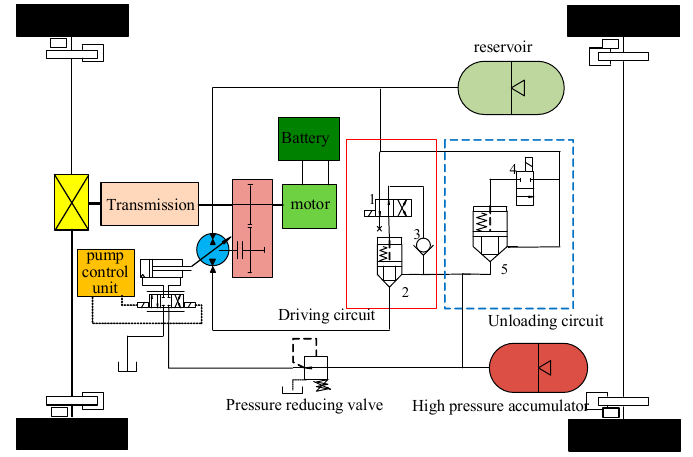
Figure 2. Structure of the hydraulic circuit. ( 1 , 4 ) Two-position two-way valve; ( 2 , 5 ) Cartridge valve; ( 3 ) One way valve.